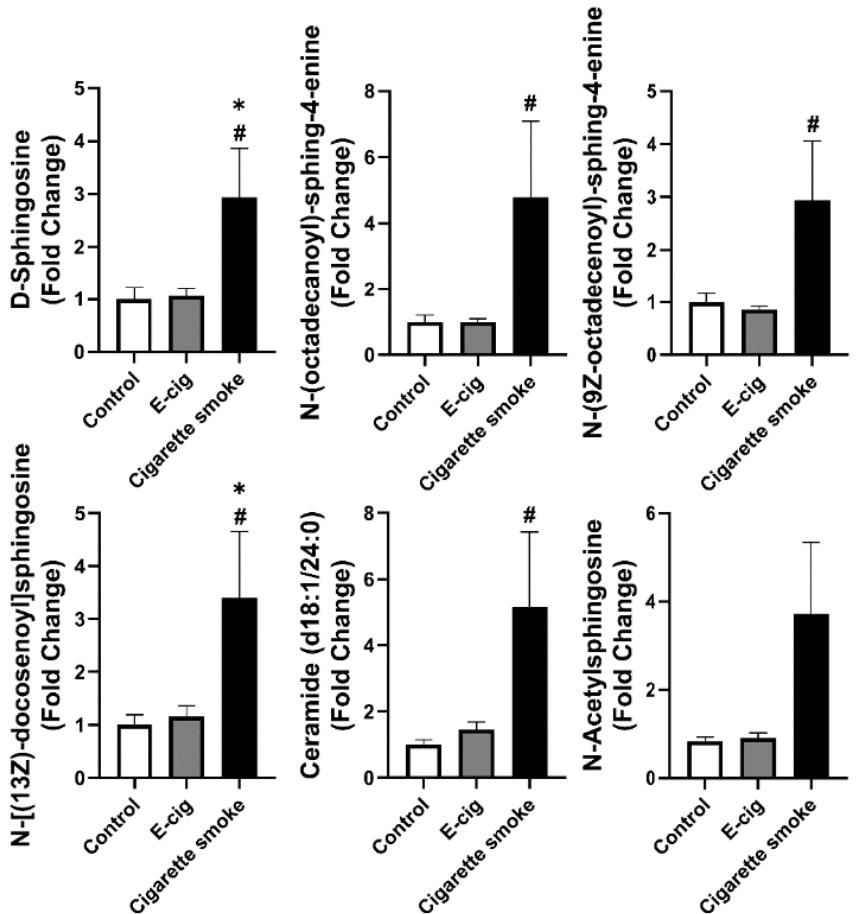
Figure 5. Metabolites from plasma analyzed from UPLC-MS from positive ion mode identified dysregulated sphingolipid metabolites in cigarette smokers. Fold changes were calculated based on the normalized area from UPLC-MS spectra, and control groups were used as a baseline. Data are shown as mean ± SEM ( n = 6 for non-smoking control and cigarette smoke groups, n = 12 for e-cig group; * p < 0.05 vs. non-smoking control; # p < 0.05 vs. e-cig).